Question: Express in one sentence what the figure is showing.
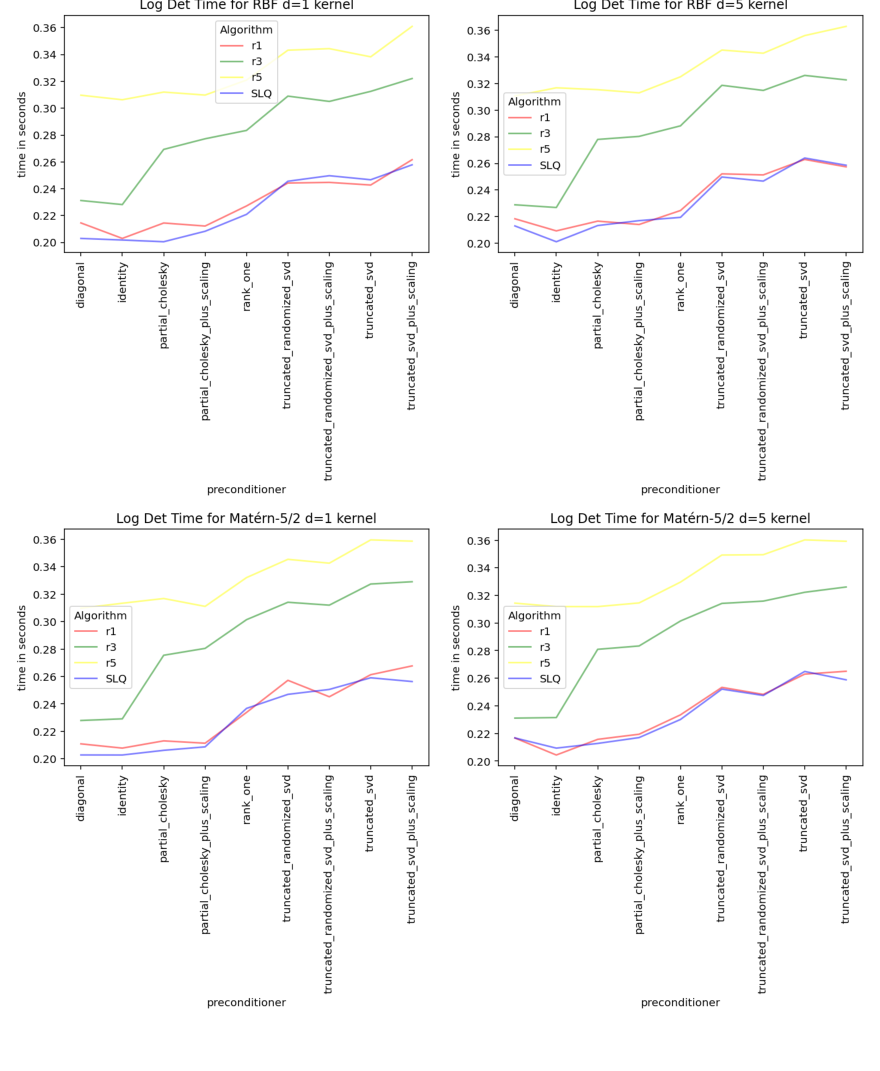
Answer: Comparison of log det algorithm running times when run with dif- ferent preconditioners. All measurements are averages over 100 randomly gen- erated kernels with n = 20, 000 as measured on a NVidia A100 GPU.